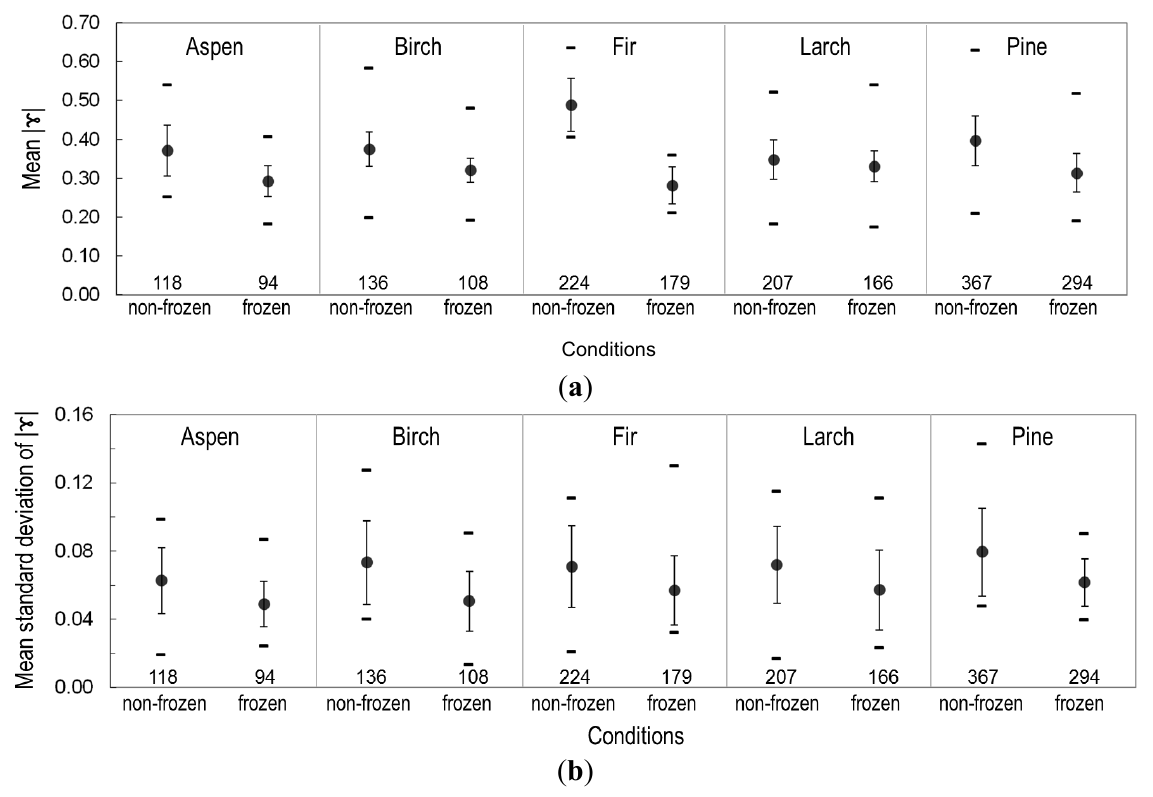
Figure 4. Mean ( a ) and standard deviation ( b ) of | γ | over dense forest (200–300 m³∙ha −1 ) by dominant tree species and environmental conditions—all sites. Symbols: average ( • ), standard deviation (┴ ┬), minimum/maximum (–). The figures at the bottom lines of the diagrams represent the numbers of samples.